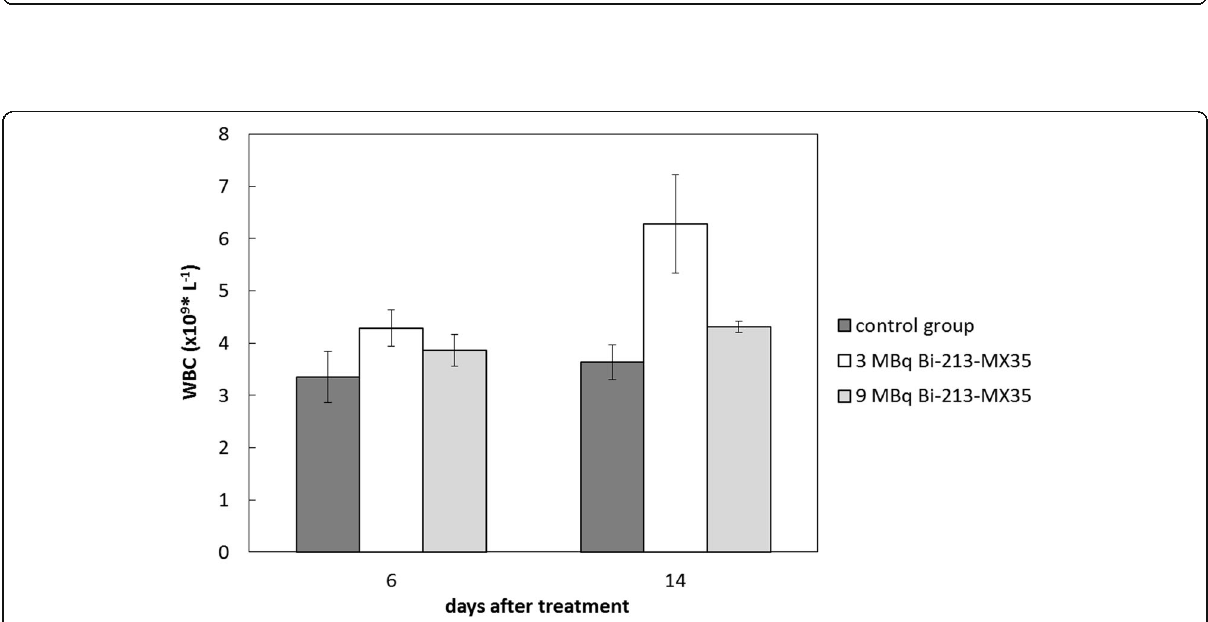
Fig. 1 Tissue sections of the abdominal wall from a reference animal treated with unlabeled MX35 visualizing a macroscopic tumor ( bottom of a and c ) and microscopic tumors ( b and d ). a and b are stained with H&E while c and d show the dense distribution (in brown ) of the MX35 antigen on tumor cells using IHC